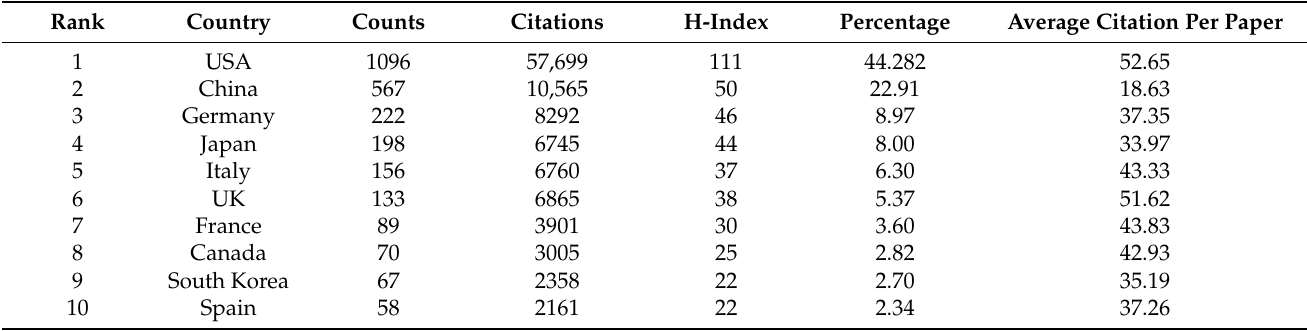
Table 1. Top 10 productive countries/regions.